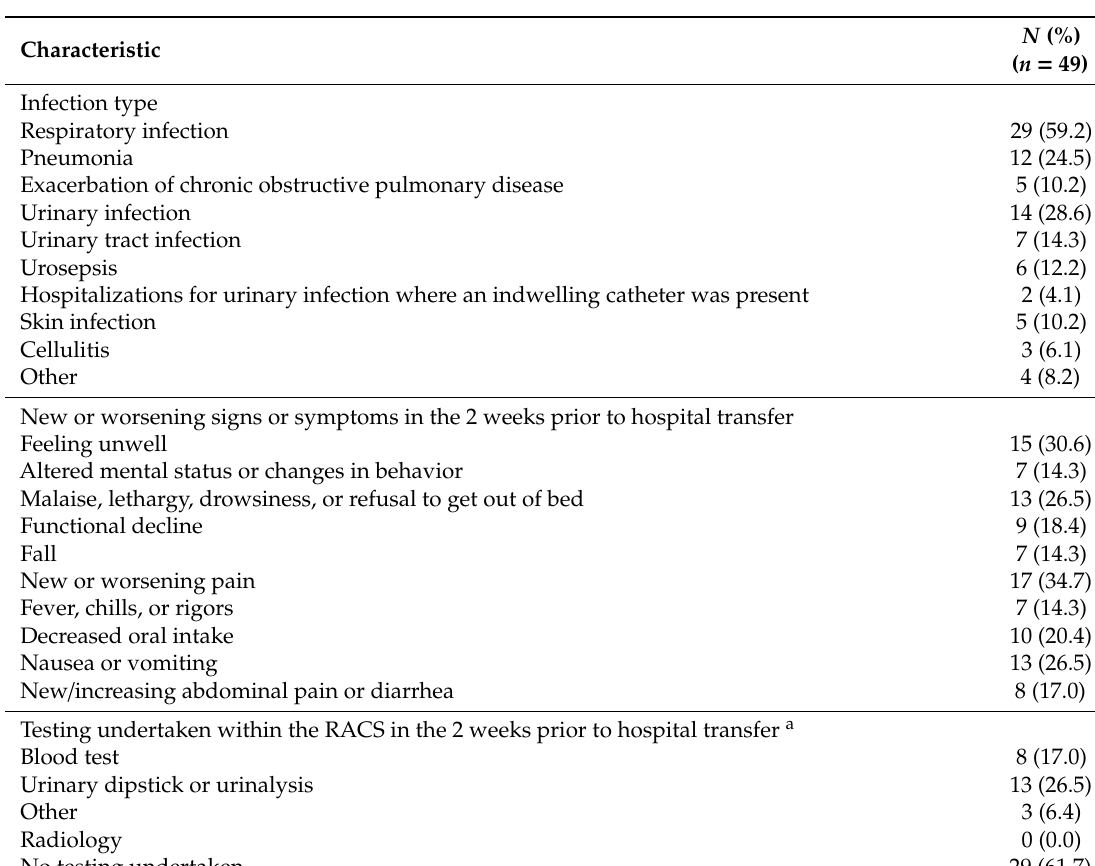
Table 3. Characteristics of the infection and resulting infection-related hospital